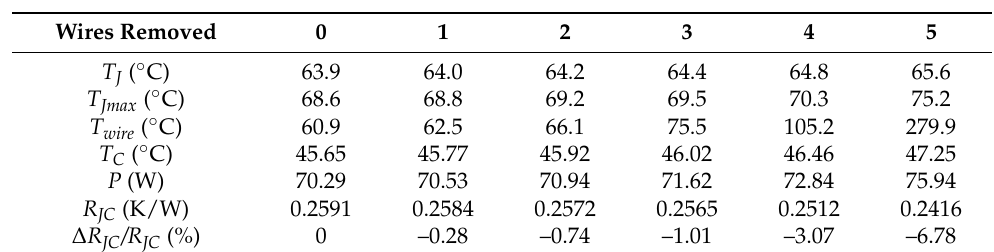
Table 2. Simulation